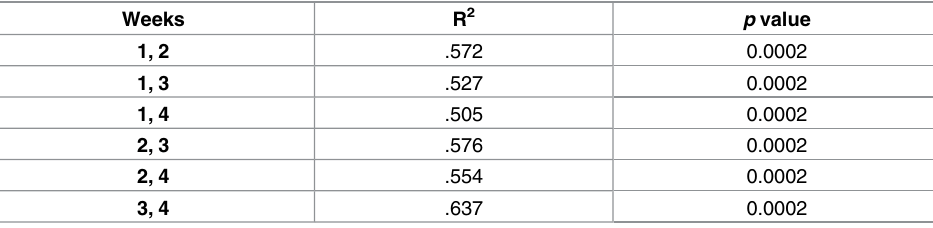
Correlations between each week-long matrix, measuring network stability across weeks 1–4. Significance values were generated by comparing the observed values with those from 4999 null networks.